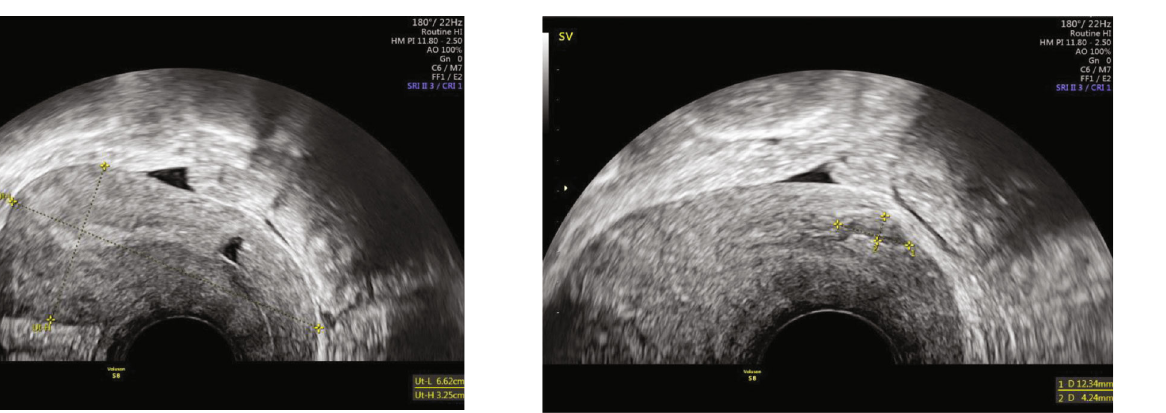
Figure 8: .12mm x 4 mm